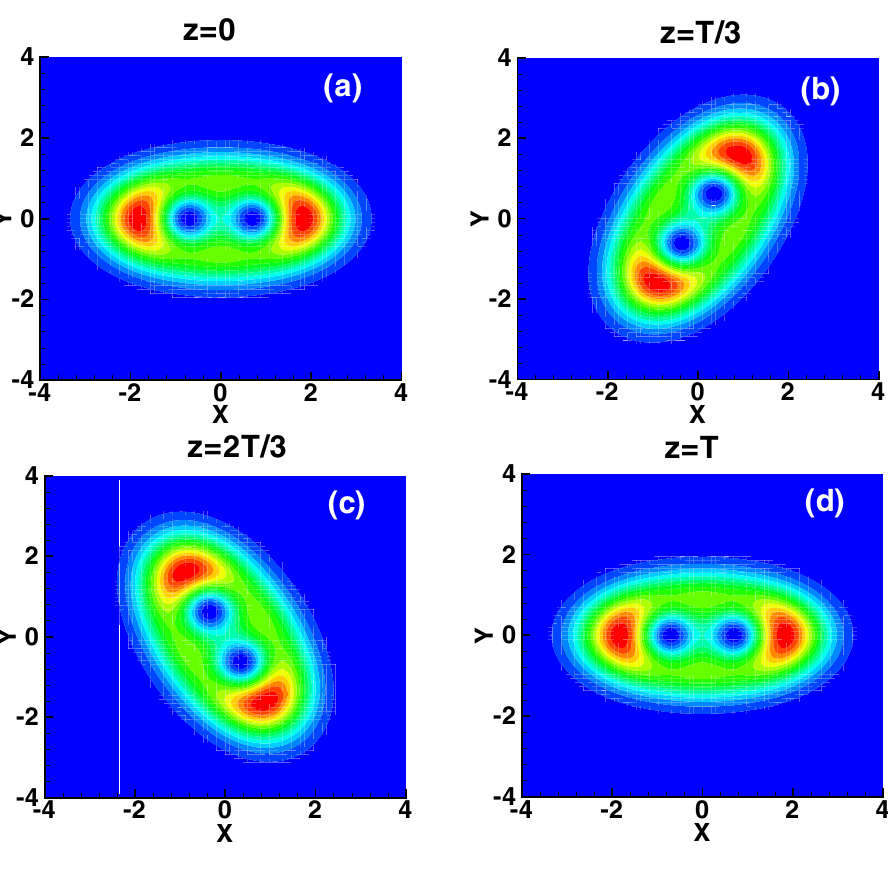
Figure 3. Evolution of the second-order mode of the spiraling elliptic Hermite-Gaussian